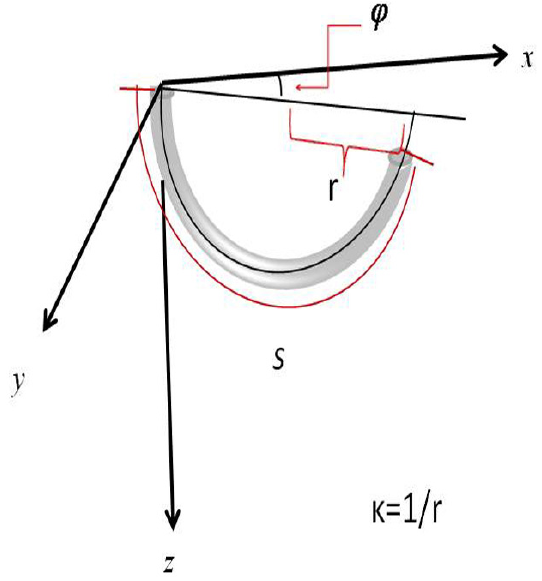
Figure 4. Kinematics of a single section of a continuum arm.